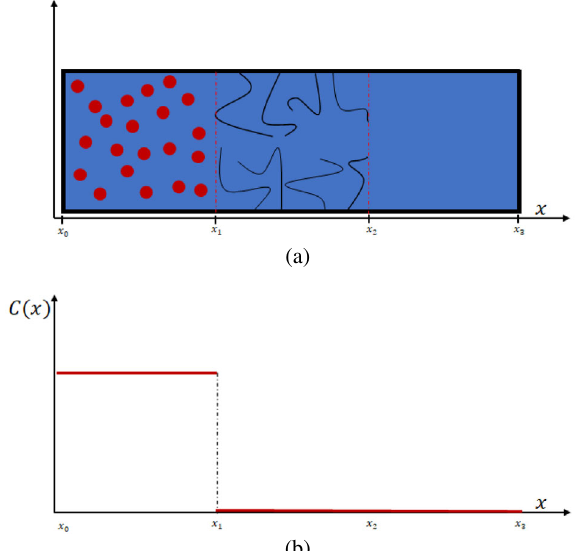
FIG. 3. The second part of the string question provided to students. Space was provided for students to show their work.